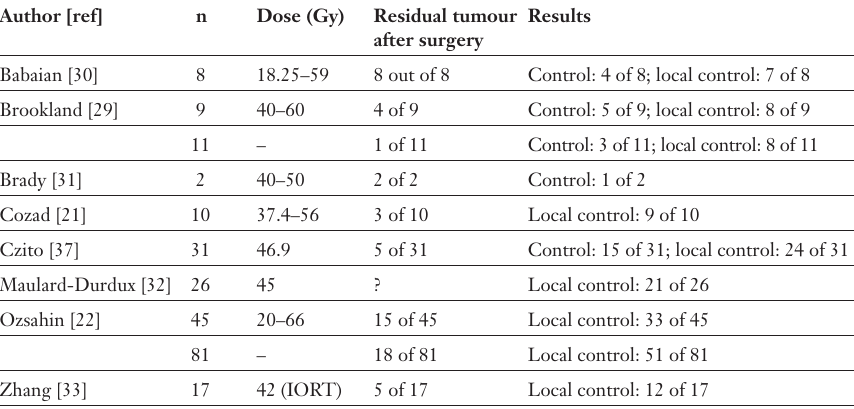
Postoperative radio- therapy in urothelial renal pelvis and/or ureter tumours: data from the